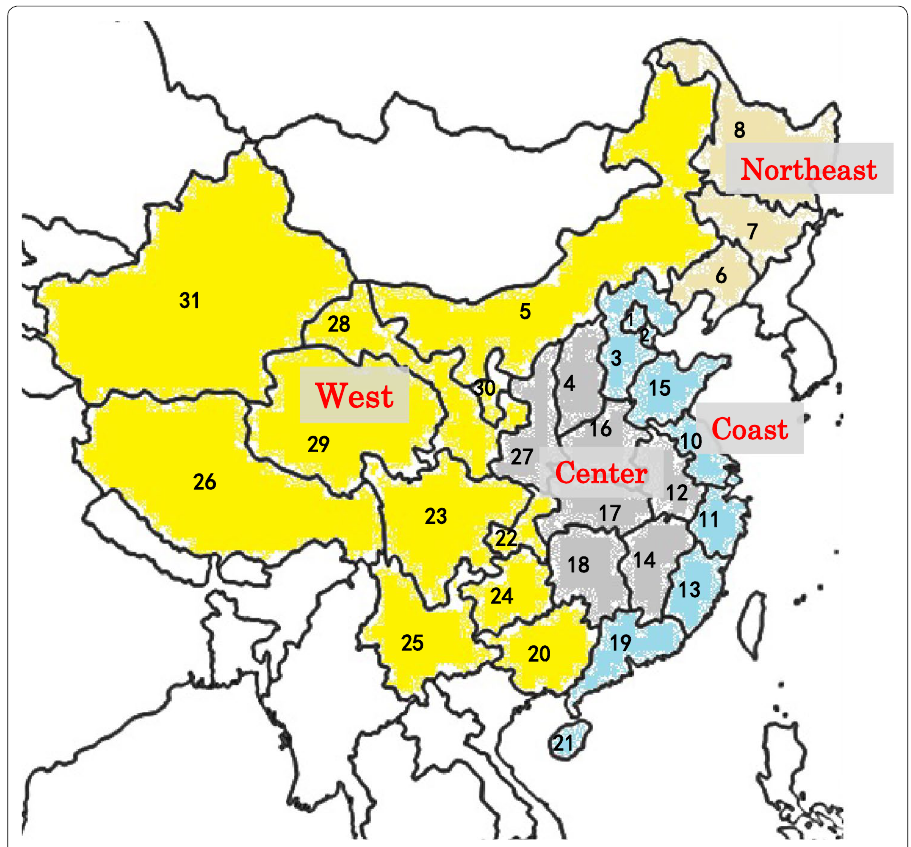
Fig. 7 Regions in mainland